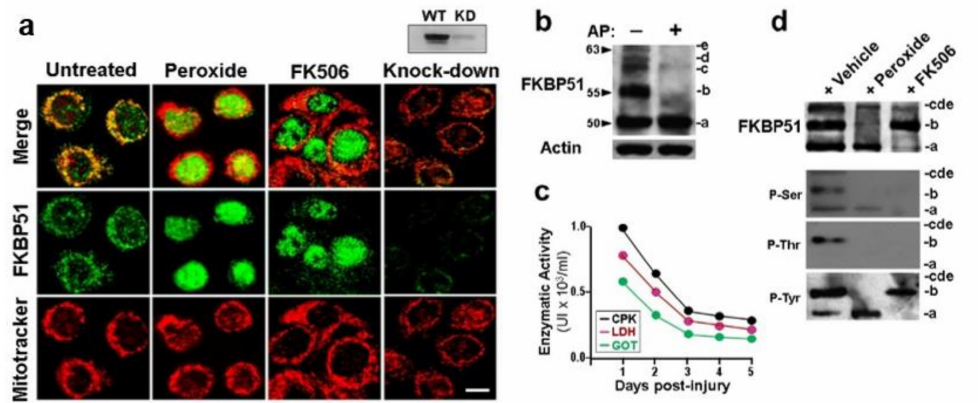
Figure 3. The phosphorylated isoforms of FKBP51 are modulated according to the type of stimulus. ( a ) Nuclear relocalization of FKBP51 (green) in N2a cells treated with H 2 O 2 as in Figure 1 or with 1 µ M FK506 for 4 h. Mitochondria are stained with Mitotracker (red). The insert shows a Western blot demonstrating the efficiency of the knockdown (KD) compared to the wild-type extract (WT). ( b ) Alkaline phosphatase (AP) treatment evidence up to five FKBP51 phospho-isoforms in N2a cells (named with letters). The MW markers are shown next to the blot. ( c ) Residual enzymatic activity in the medium. ( d ) The stripping membrane of the Western blot for FKBP51 shown on the top demonstrates that the relative abundance of each phospho-amino acid. (a–e) is differentially affected when 3D frontal cortex slices are treated with H 2 O 2 or